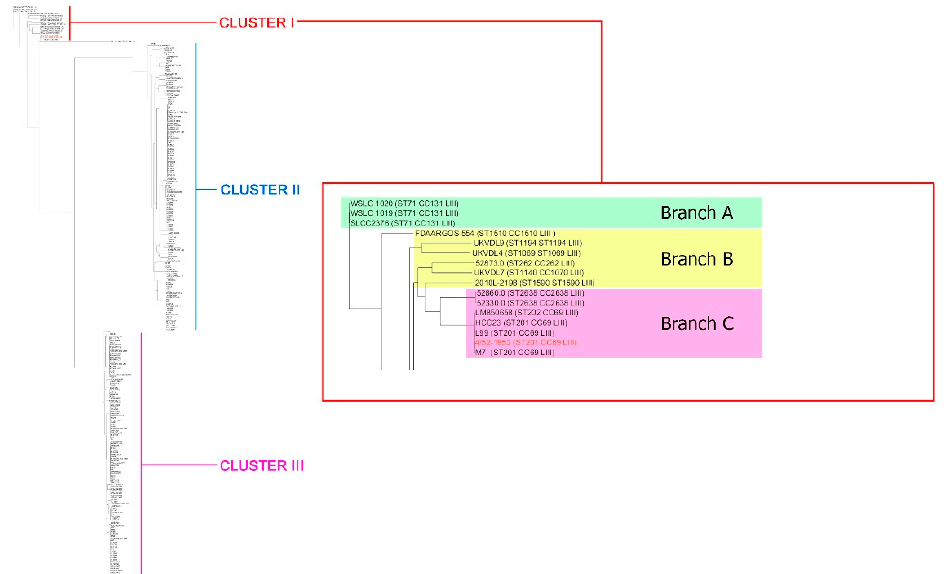
Figure 2. Phylogenetic tree demonstrating the relationship between L. monocytogenes strain 4/52- 1953 and other 256 whole genomes chromosome sequences of L. monocytogenes isolates available in NCBI GenBank (https://www.ncbi.nlm.nih.gov/, accessed on 29 May 2022). L. monocytogenes strain 4/52-1953 is highlighted in red. Comparison of full genomes of L. monocytogenes demonstrates the separation of strains into three different clades.